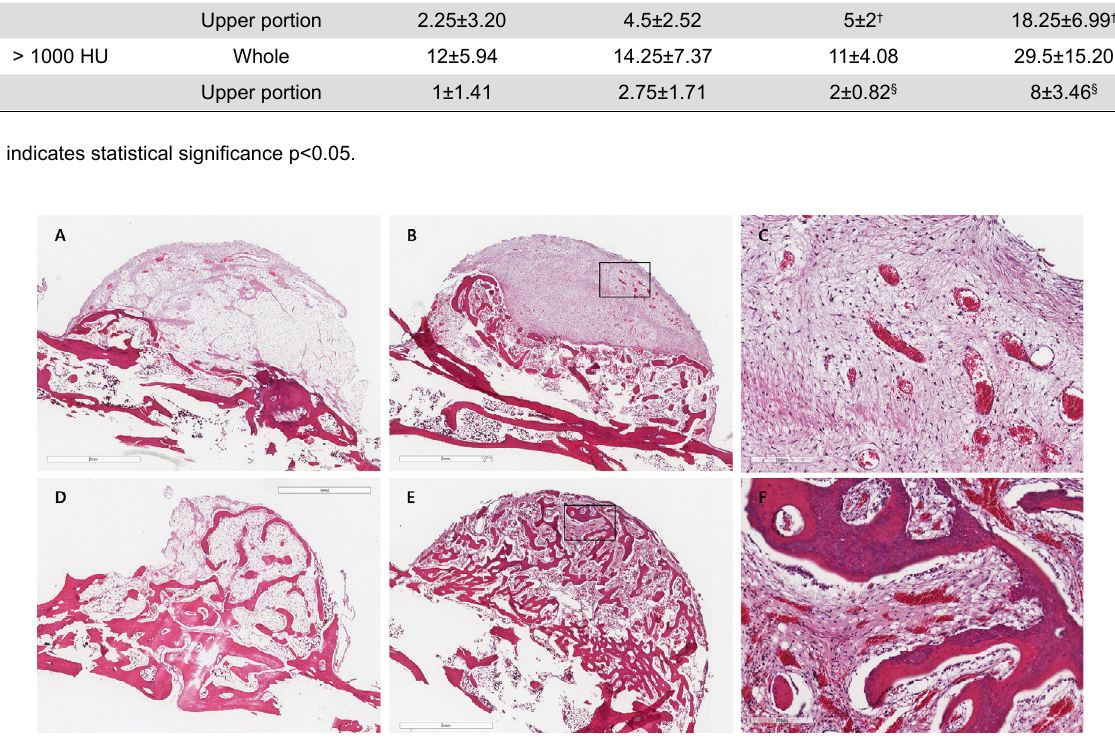
Figure 6- Histological images of the specimen shows new bone formation in the area below the cap, especially at the site of the rhBMP-2